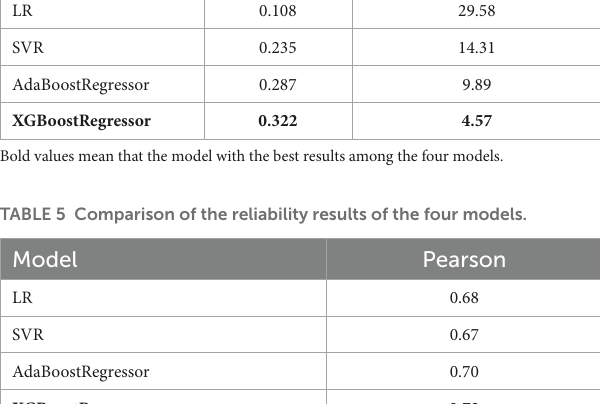
TABLE 2 Examples of Chinese words for each SC-LIWC category. SC-LIWC category Example words